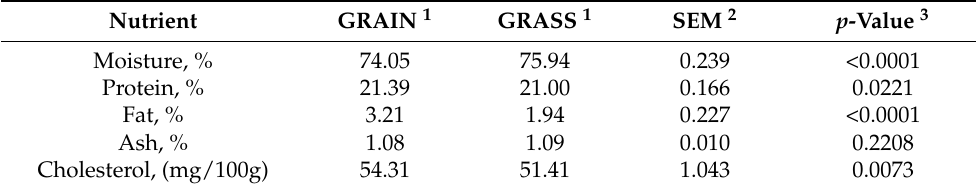
Table 3. Least square means for the effect of finishing system on the proximate nutrient composition of raw tissue from the longissimus dorsi of grain- or grass-finished bison heifers.